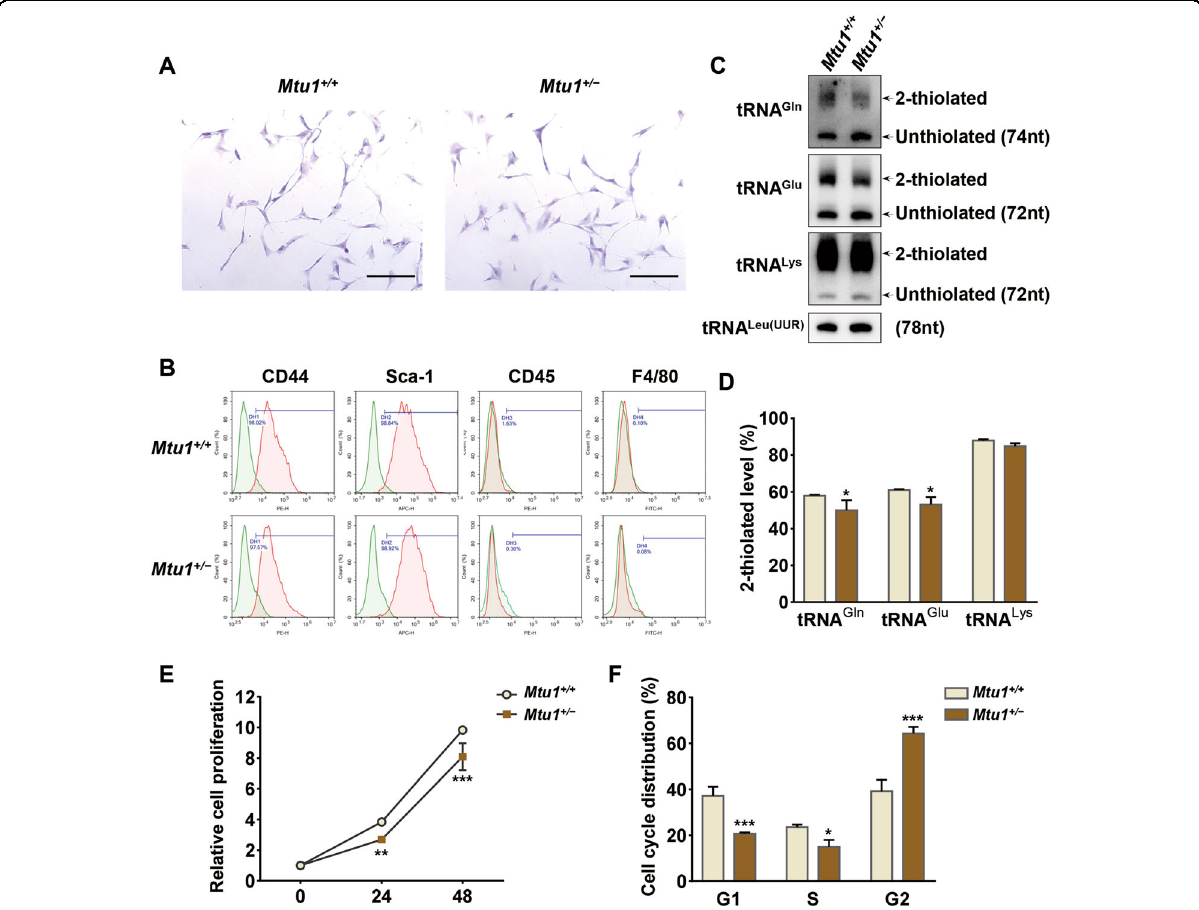
Fig. 2 Mtu1 + / − BM-MSCs had reduced 2-thiouridylation levels of mitochondrial tRNAs. A Crystal violet staining of mouse BM-MSCs. Scale bars: 100 μ m. B Representative results of fl ow cytometric analysis for cell-surface markers. Green peaks, isotype control; red peaks, speci fi c antibodies. C 2- Thiouridylation level analysis of mt-tRNAs by APM gels. D Proportion of the 2-thiouridine levels of tRNAs. The proportion values are expressed as ratios (%) of the average of 2-thiouridine modi fi ed tRNA levels to total levels. E Cell proliferation assay. Cell counts were carried out on hours 0, 24, and 48 after seeding. F Cell cycle analysis. Flow cytometry results indicating the proportion of cells in the G1, S, and G2 phase. * P < 0.05; ** P < 0.01; *** P <